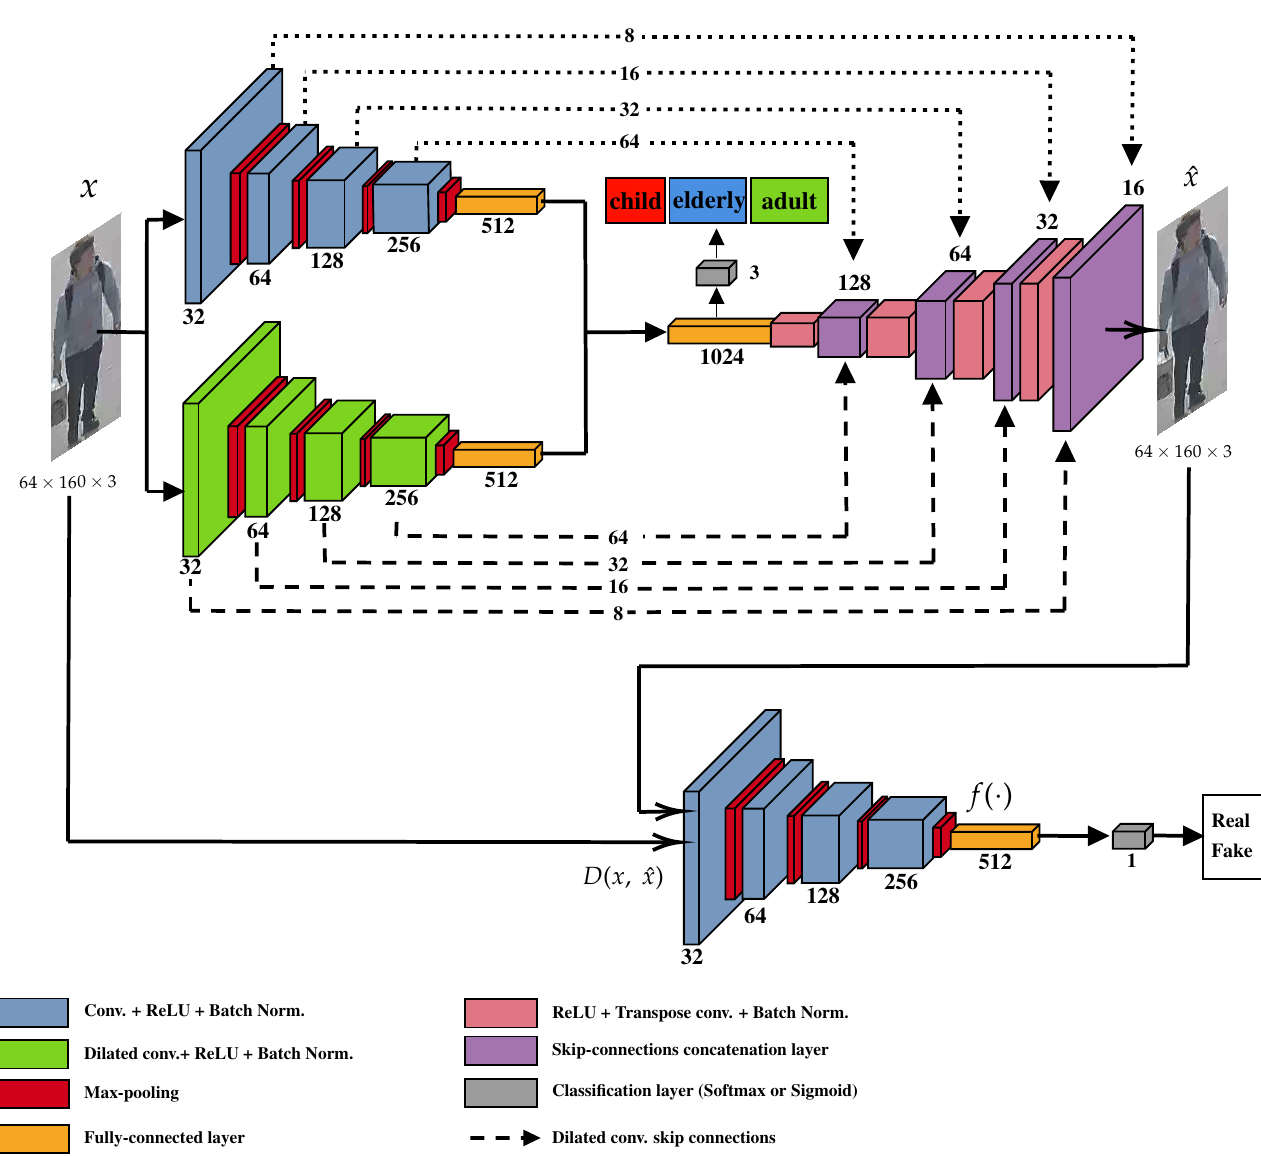
Figure 1. The proposed model architecture. The input image x size is 64 × 160 × 3 for both the encoder and the discriminator D ( x , ˆ x ). Encoder architecture has two sub-networks: a conventional CNN and a dilated convolutional CNN (DCN). Both CNN and DCN have 3 × 3 convolutional layers, with DCN having a dilation factor of two. At the end of both networks, the latent vectors are concatenated and become the input of the generator where the input image x is reconstructed as ˆ x through the transpose convolution layers. In addition, a Softmax layer is added to this latent vector for the ablation test. When the parallel encoder is trained with the labeled data, classification is performed in this layer. Partial skip-connections from CNN and DCN into the generator model alleviate the vanishing gradient and the mode collapse phenomenons observed in deep learning models. Afterward, both the input image and the reconstructed images are sent through the discriminator. The images are classified as either real or fake in the sigmoid layer (with one node). The fully connected layer of the discriminator f ( · ) is utilized for anomaly detection during the inference. Each input image, whether it belongs to a normal-designated class or an anomaly-designated class, results in a reconstruction score, based on Equation